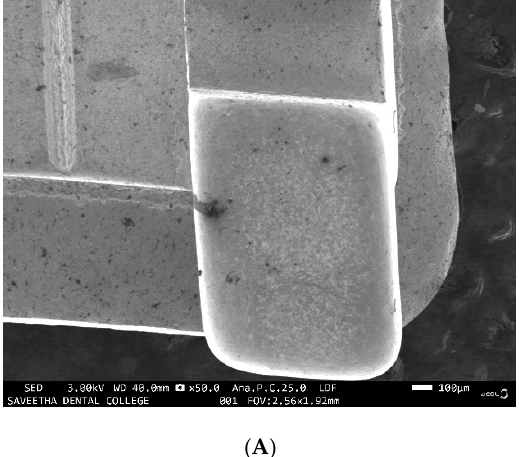
Figure 1. SRB growth on the surface of TMA wire by SEM under ( A ) lower magnification of 100× and ( B ) high magnification of 250×.